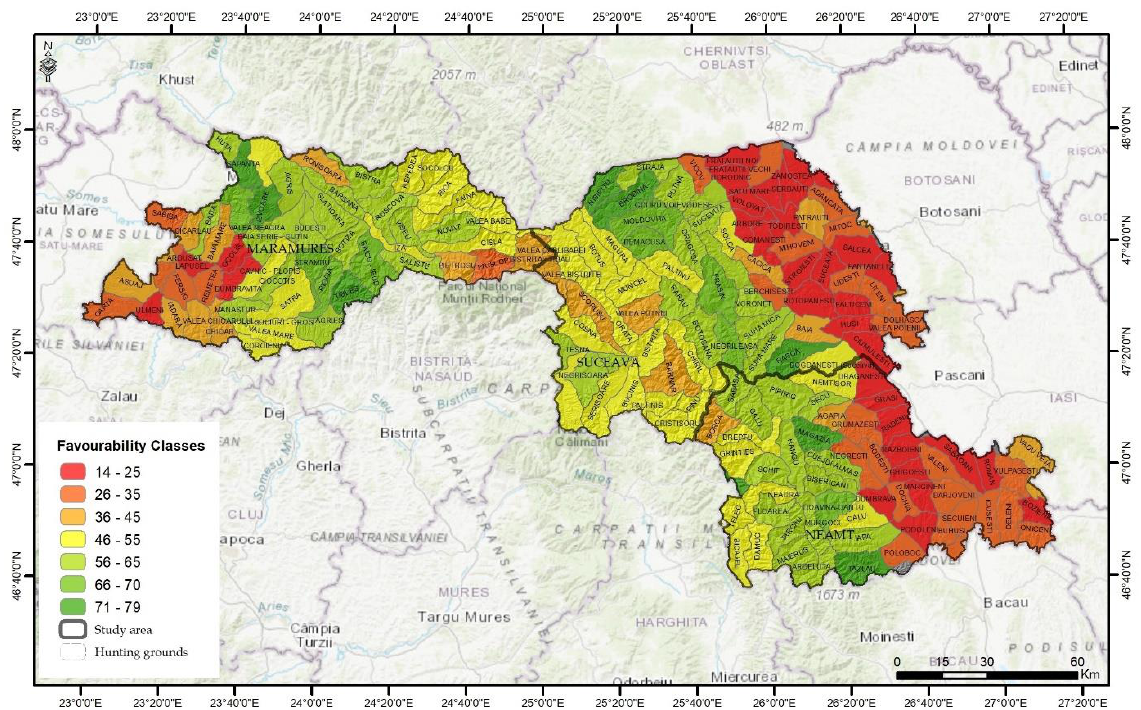
Figure 3. Favourability of habitats in Suceava, Neamț , and Maramureș counties for the European bison.